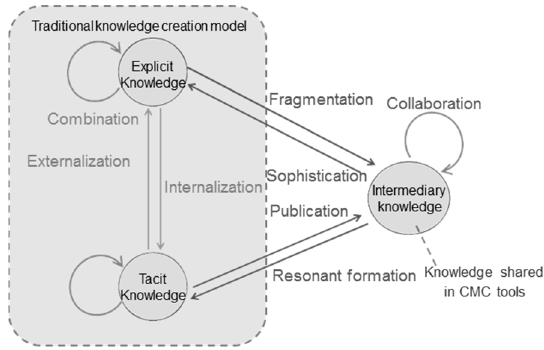
Figure 7. Intermediary knowledge model [38,76–78].